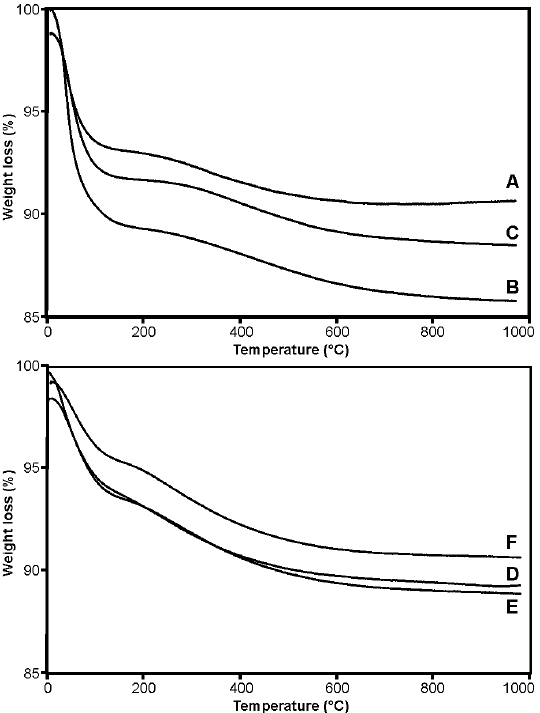
Figure 1. The thermogravimetric analysis (TG) of the silica carriers (A – F). The FTIR measurements made for the silica materials A – F are shown in Figure 2. A large peak, expanded from 3000 to 4000 cm −1 , corresponds to the stretching vibrations of SiO-H and HO-H. The bands corresponding to symmetric vibrations of Si-O-Si are present in the range of 1200 – 1147 cm −1 (maximum at 1108 cm −1 ), and the asymmetric ones at 802 and 474 cm −1 . The bands at 1630 and 957 cm −1 correspond to the HO-H bending vibrations [29,30]. Grinding the carrier under normal conditions increased the amount of water on its surface. As a result of the association of adsorbed H-O-H molecules with the Si-OH group, a shift towards lower wavenumbers (from 957 to 937 cm −1 ) is observed. In addition, in the case of the silica synthesized with the increased amount of TEOS, a band at 1400 cm −1 was observed, most likely originating from the swing vibrations of the O-H or C-H groups (CH 2 with TEOS) [31,32].